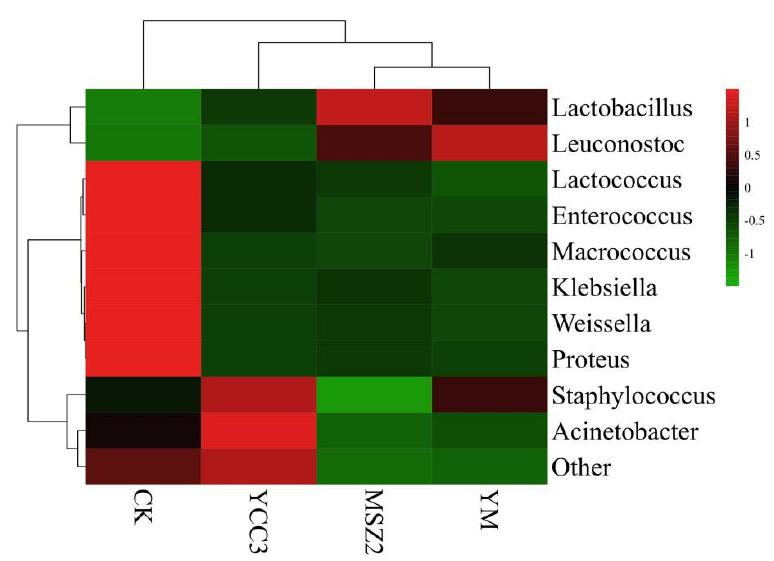
Figure 3. Bacterial community composition heatmap at genus level in fermented sausage. The colors correspond to normalized mean levels from low (green) to high (red).